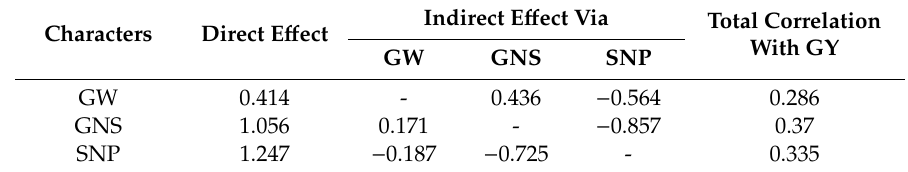
Table 2. Direct and indirect e ff ects on grain yield (GY) via thousand-grain weight (GW), grain number per spike (GNS) and spike number per plant (SNP) in a two-year pot